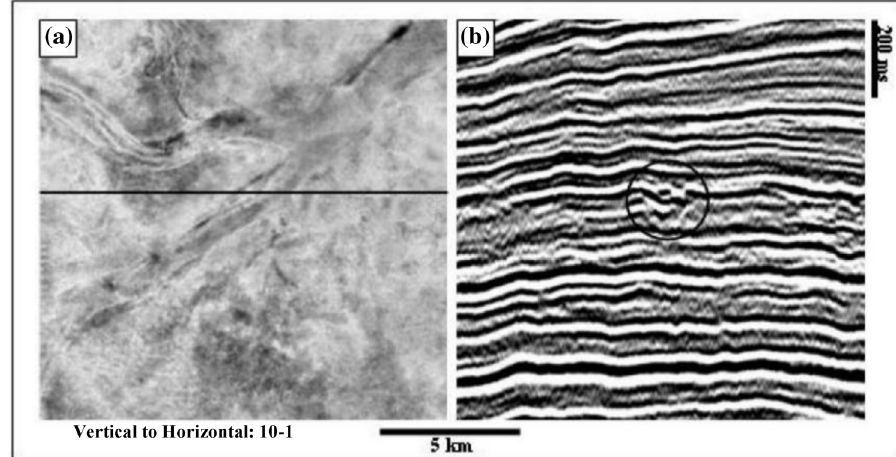
Fig. 18 a Root mean square volumetric seismic amplitude attribute map, within 30 ms of the upper Turonian sedimentary rocks. b Seismic profile through the Azadegan High (Abdollahie Fard et al.